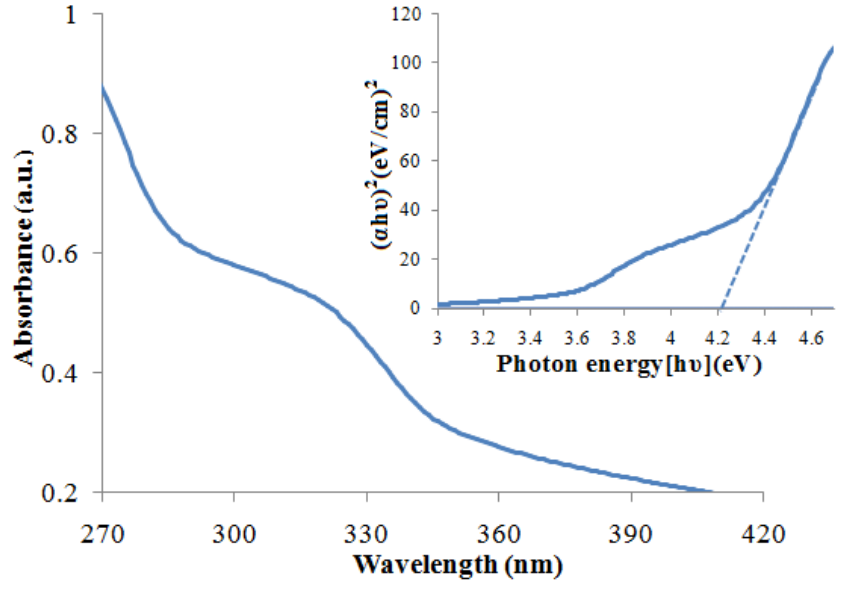
Figure 5. UV–Vis absorption spectra and Tauc plot of the ZnS nanoparticles.